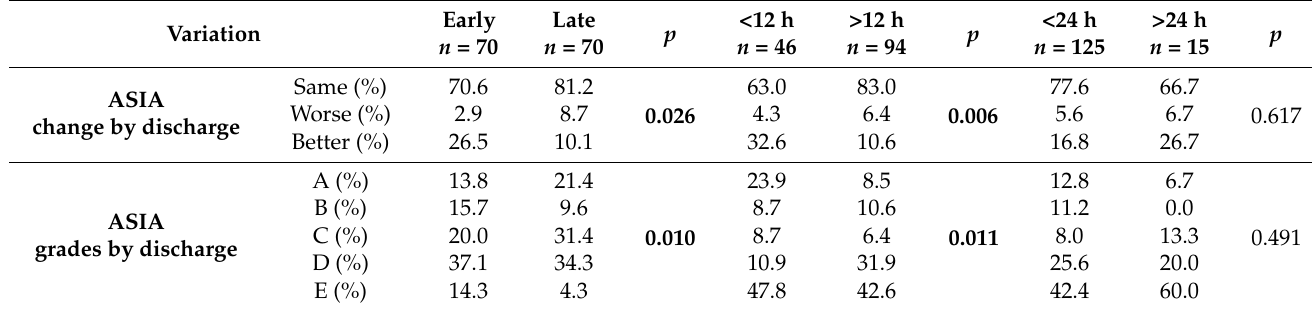
Table 3. Changes in ASIA grades by discharge in patients with acute MSCC, stratified by different surgical timing cutoffs: left column, by median time interval from admission to surgery (i.e., within vs. after 16 h); middle column, within vs. after 12 h; right column, within vs. after 24 h. Bold typeface denotes statistically significant difference.